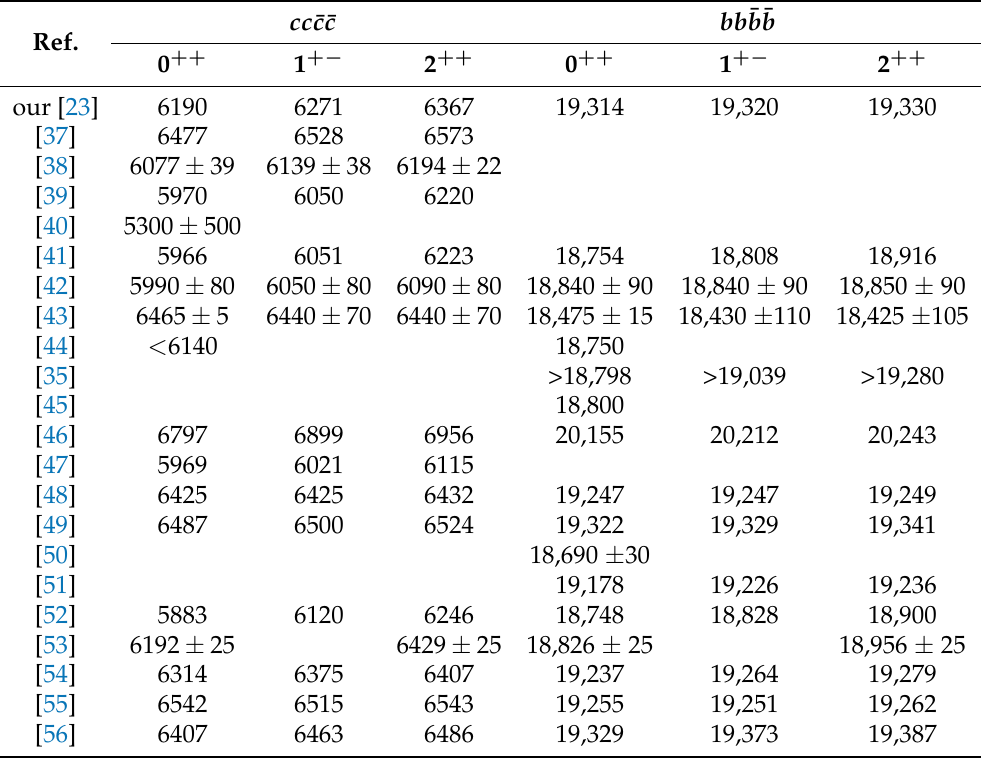
Table 13. Comparison of theoretical predictions for the masses of the ground states of the neutral ( QQ )( ¯ Q ¯ Q ) tetraquarks (in